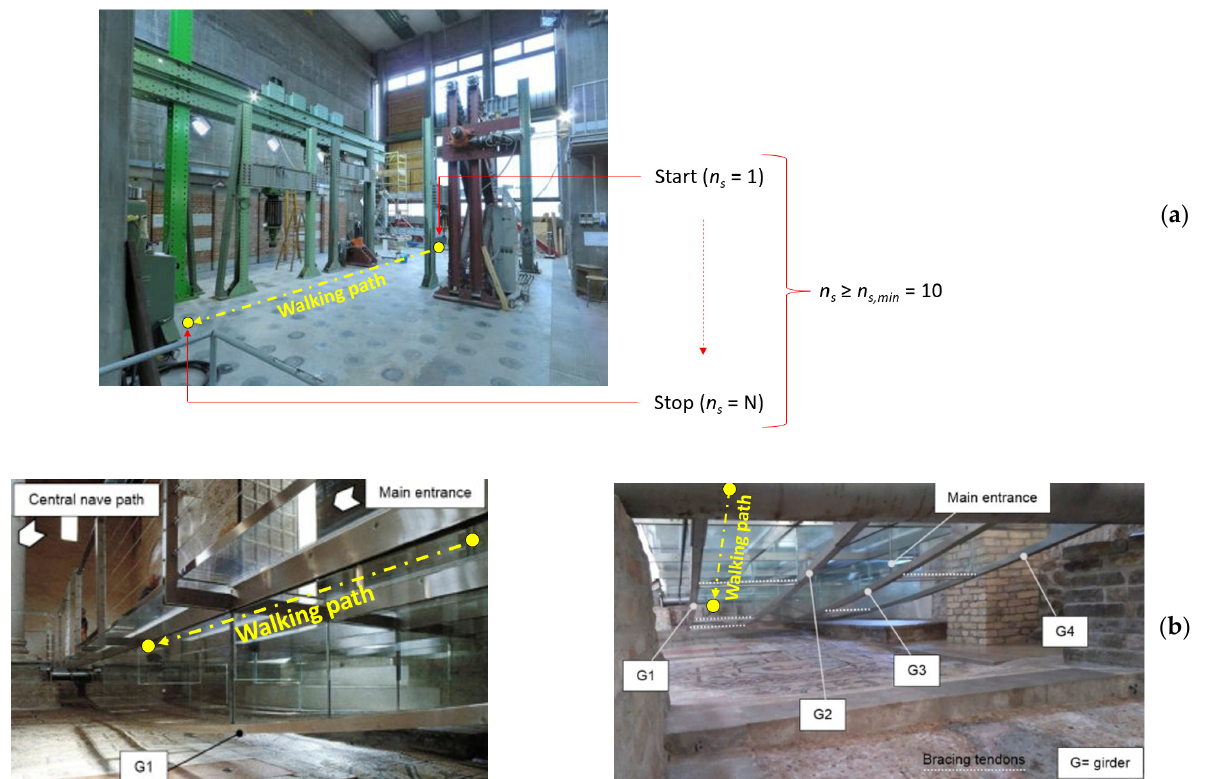
Figure 4. Reference ( a ) rigid concrete floor (SLAB#1) and ( b ) flexible glass SLAB#2 system for W0 body CoM measures (figure ( b ) adapted from [10] with permission from Elsevier ® , license agreement n. 5223670279902, January 2022).